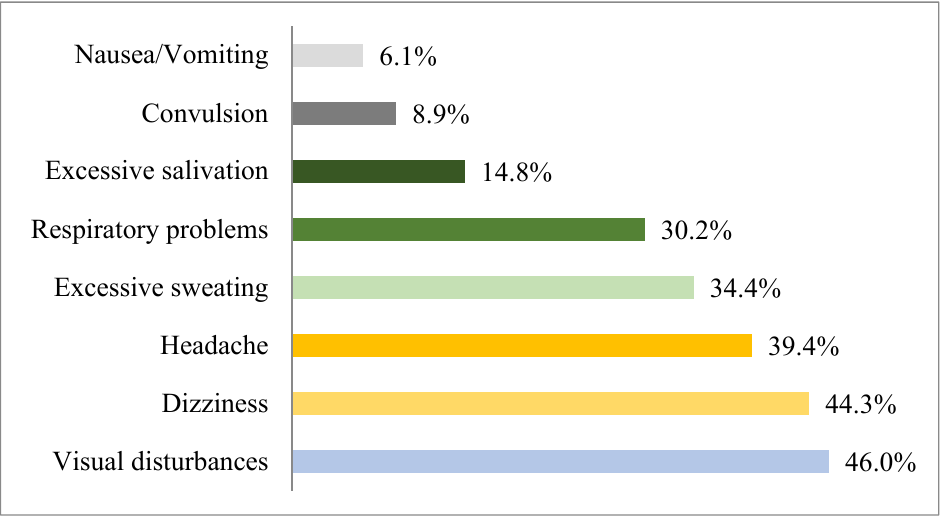
Figure 6. Biplot of perception of pesticide risks and social and demographic characteristics of inter-